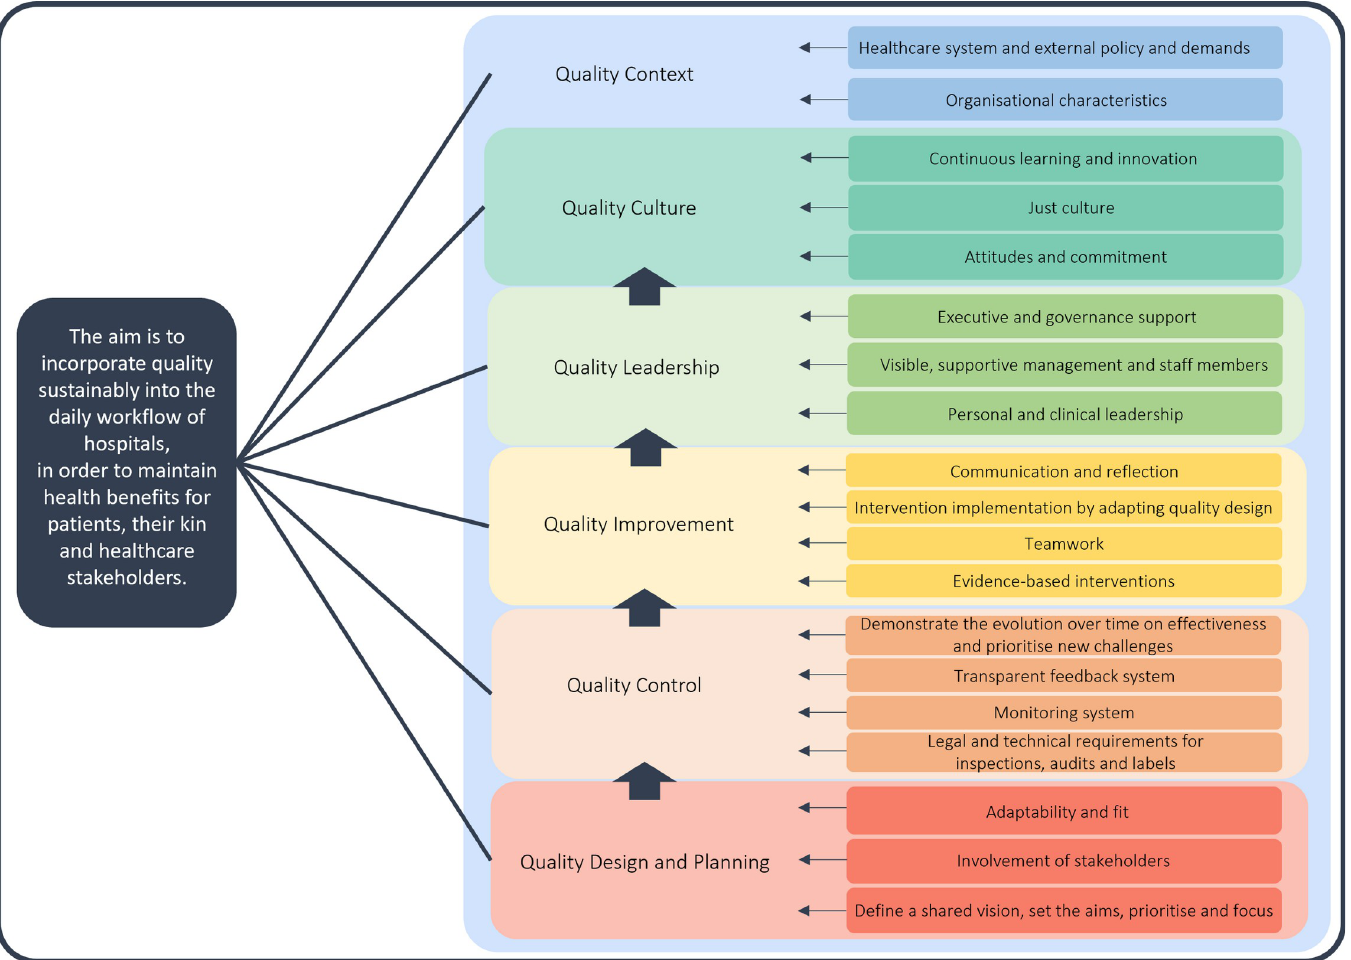
Fig 2. Integrated co-creation roadmap towards sustainable quality of care. Each colour represents a different driver. Each driver is linked to at least two building blocks. It is recommended to read this roadmap from the bottom to the top, starting with ‘Quality Design and Planning’. ‘Quality Context’ is visualised as an overarching driver.